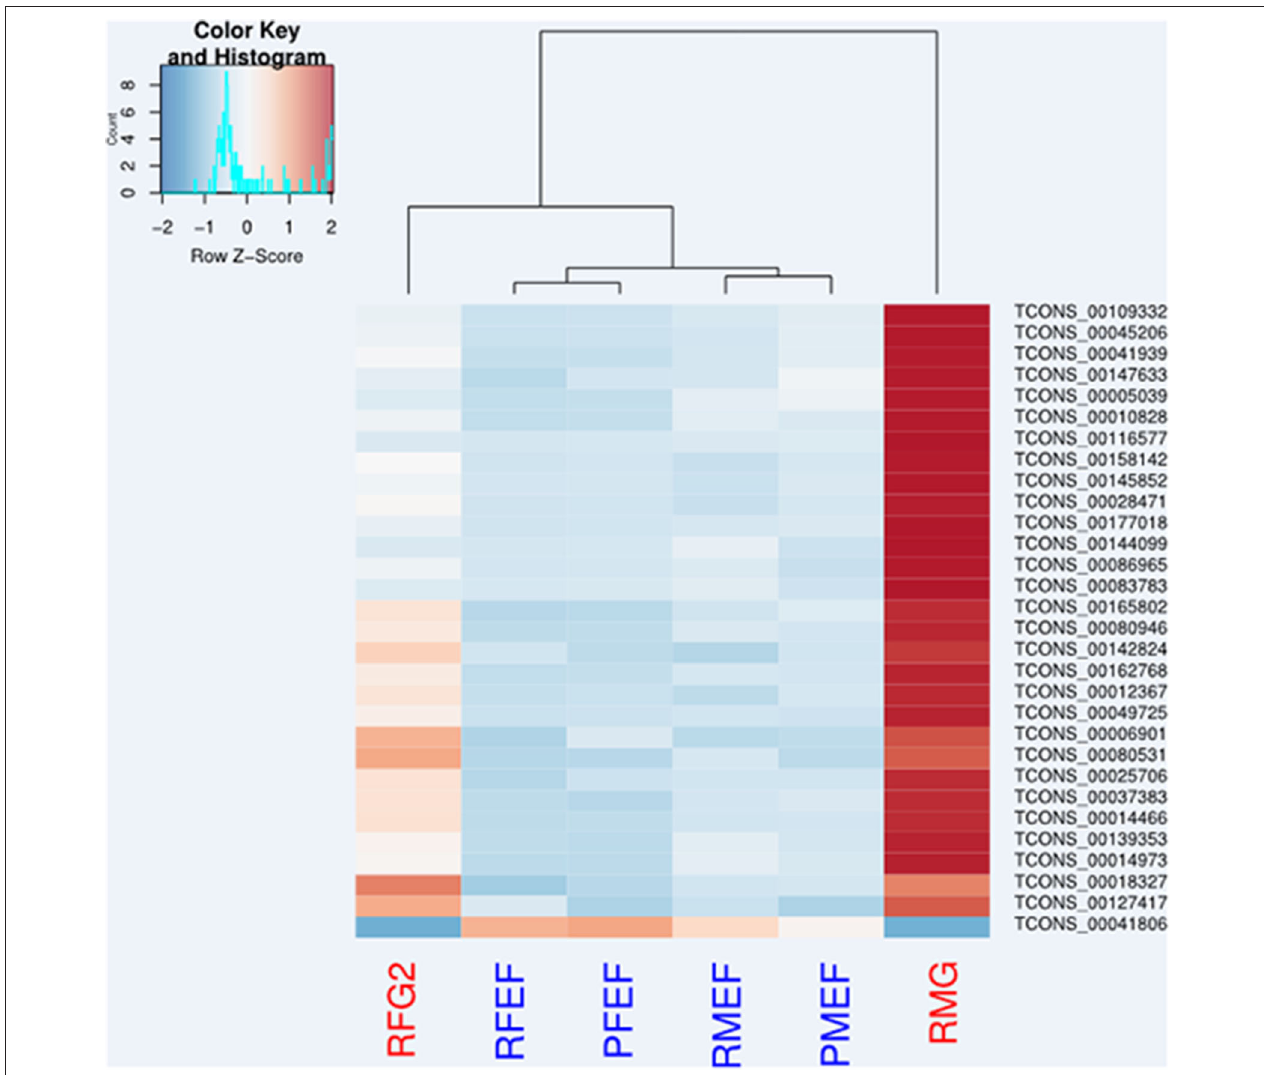
FIGURE 5 | Sample-to-sample distances. Heatmap performed using DESeq2 shows the Euclidean distances between sylvatic (red) and reared samples (blue) as calculated from the regularized log transformation expression data of the 30 most differentially expressed (DE) contigs between environment-species. see sample information ( Table 1 ).